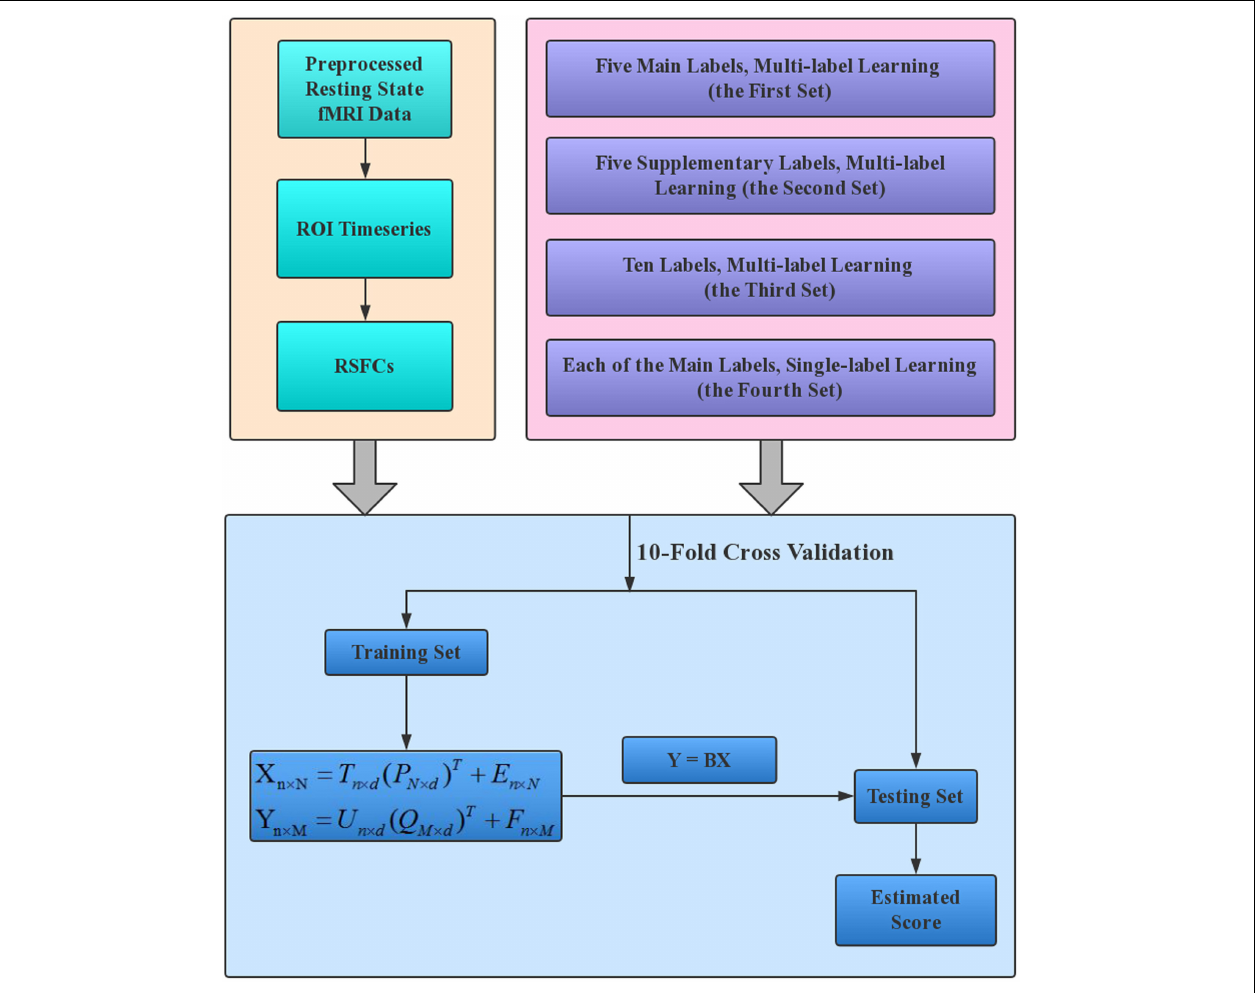
FIGURE 1 | The working flowchart of the proposed estimation framework. The resting state fMRI data of HCP 1200S release were analyzed in this study, and RSFCs provided on the HCP website (https://db.humanconnectome.org/) were directly used to establish the estimation models. Each of the four label sets in the upper right box corresponds to one set of